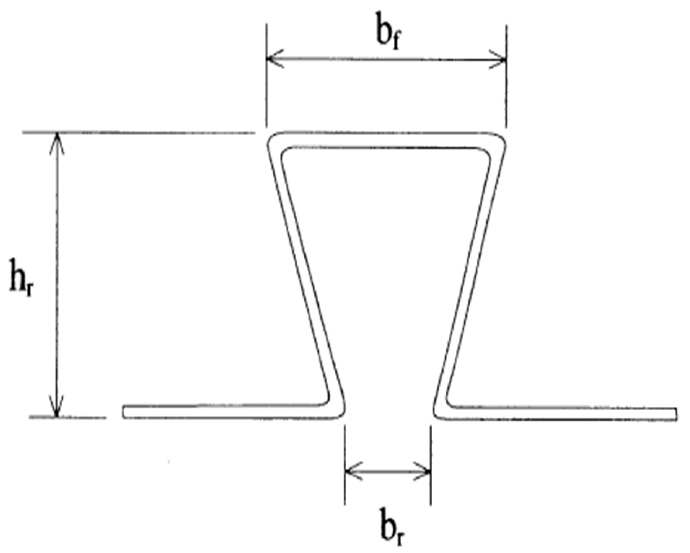
Figure 1. Generic shape of the profiled sheet rib. hr—height of rib, bf—width of flange, and br—width opening of ribs.